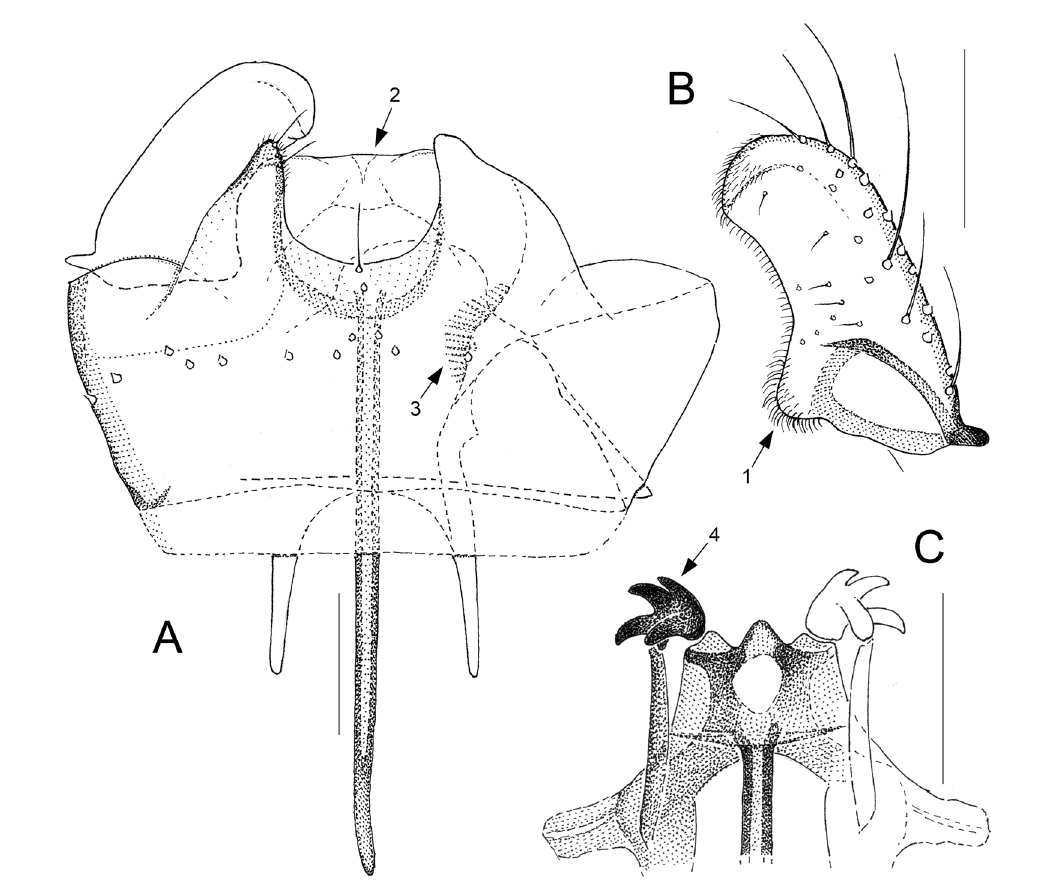
Fig. 16. Glemparon tewaipounamu sp. nov., holotype, ♂ (NZAC, no. CEC1418). A . Genitalia, ventral. B . Gonostylus, ventromedial. C . Apex of ejaculatory apodeme and tegmen, ventral. Scale bars = 0.05 mm. Numbered arrows indicate diagnostic characters (see